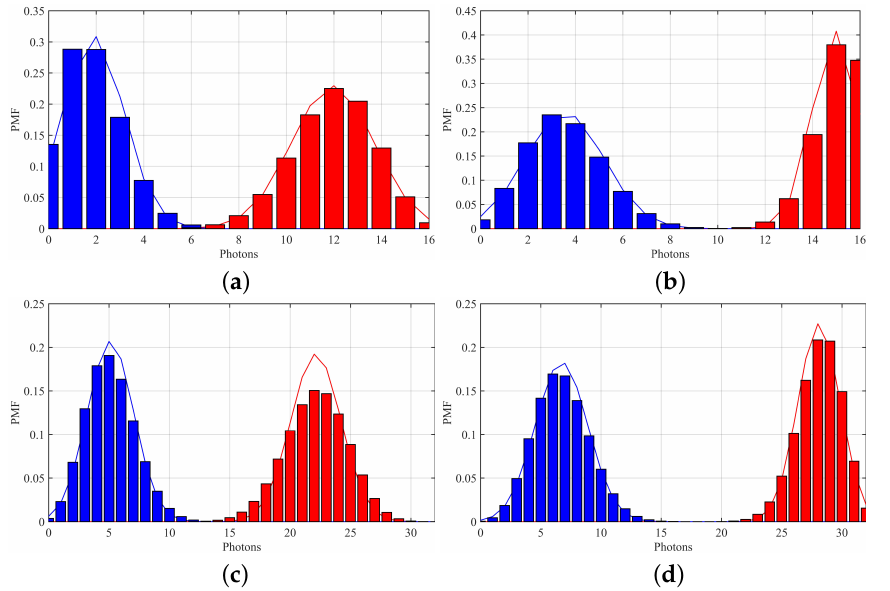
Figure 2. The probability mass function of time-gated SPAD array, the distribution of “1” signal and “0” signal is shown in red and blue respectively. ( N g = 16, T C = 2 T d , λ 1 = 5/ T C , λ 0 = 0.5/ T C